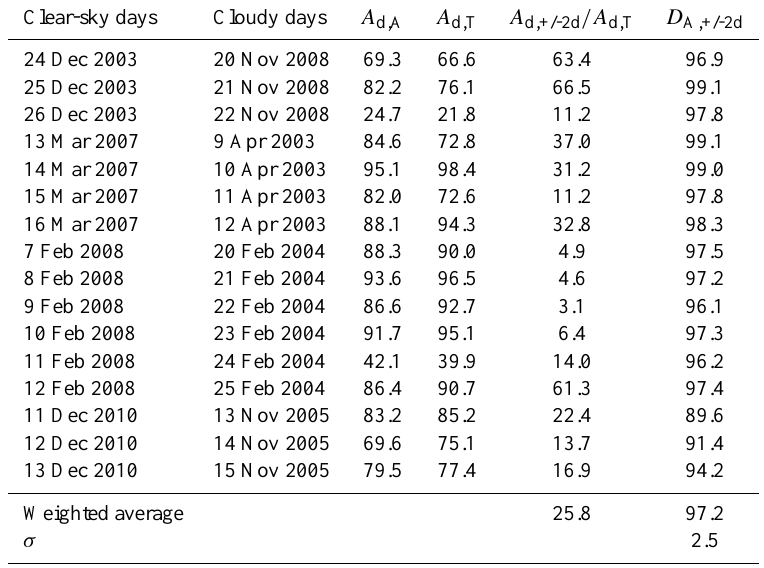
Table 12. Efficiency and accuracy of the combined use of steps 1 and 2. The test is performed using spatio-temporal additional cloud masks. Values in